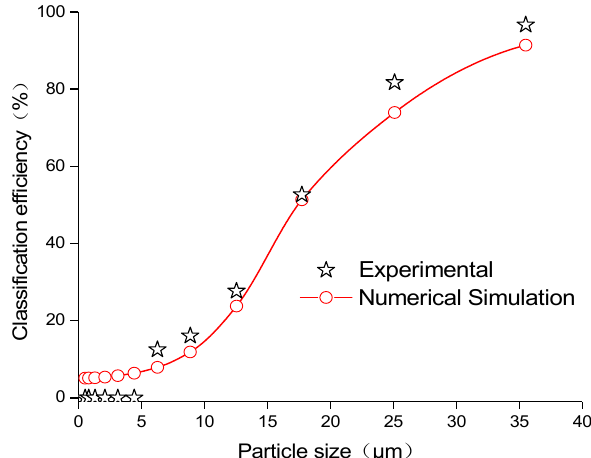
Figure 2. Comparison of classification efficiency curves between numerical simulation and experiment.